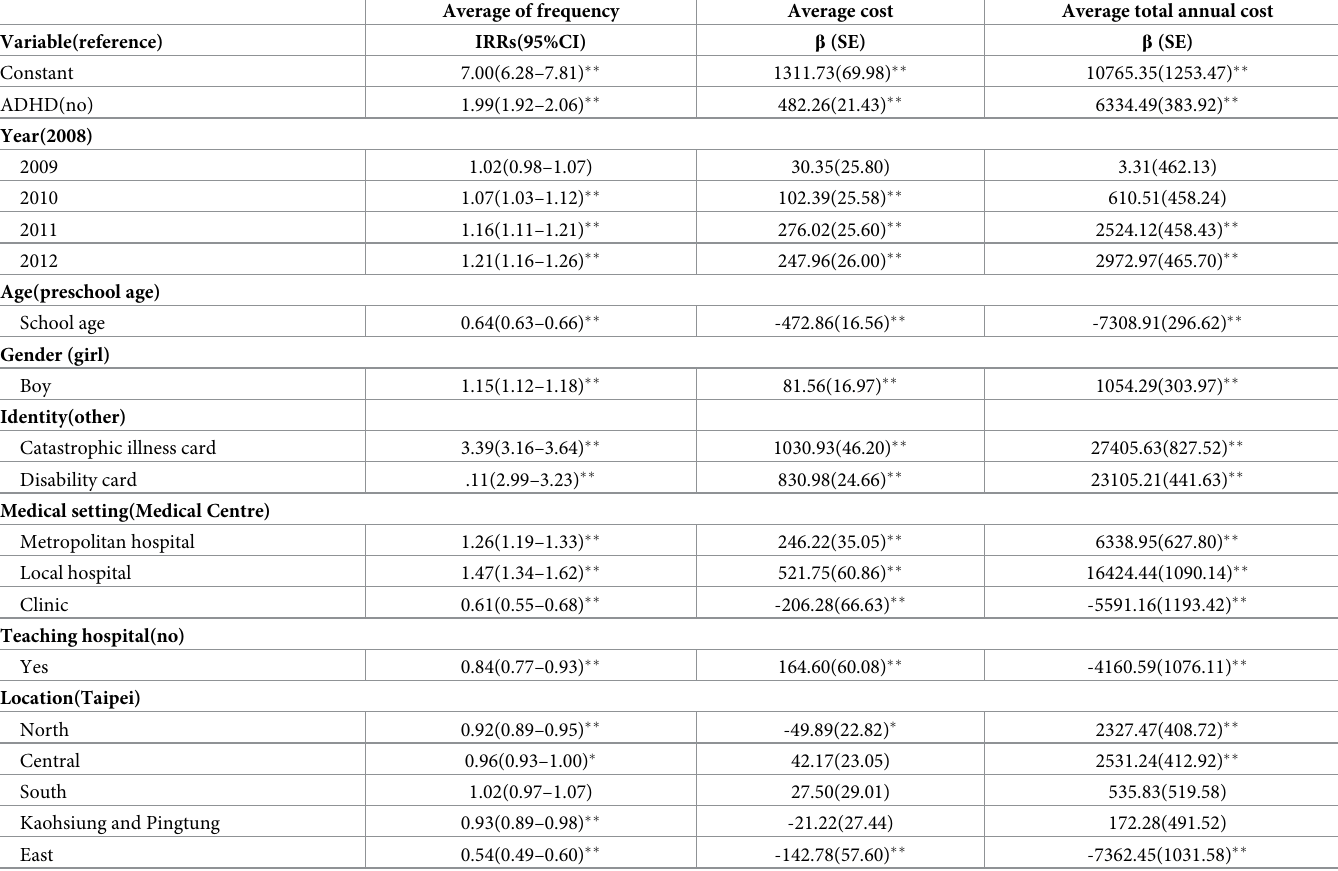
Table 4. Results of multiple linear regression model of rehabilitation use